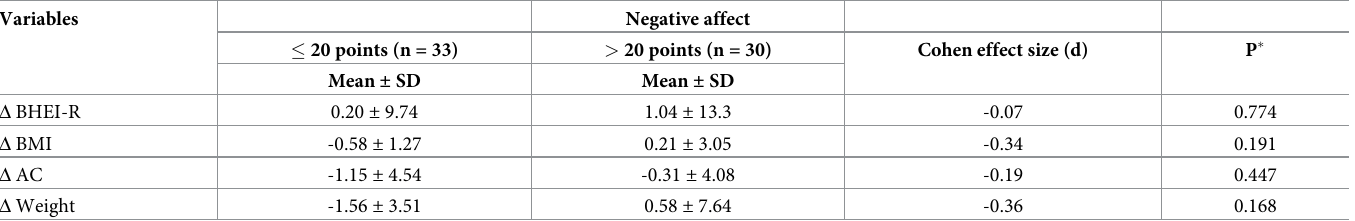
Table 5. Classification of negative affect (dichotomized at the median) associated with the BHEI-R, BMI, AC and weight of patients with metabolic syndrome, Porto Alegre, Brazil (n = 63). Variables